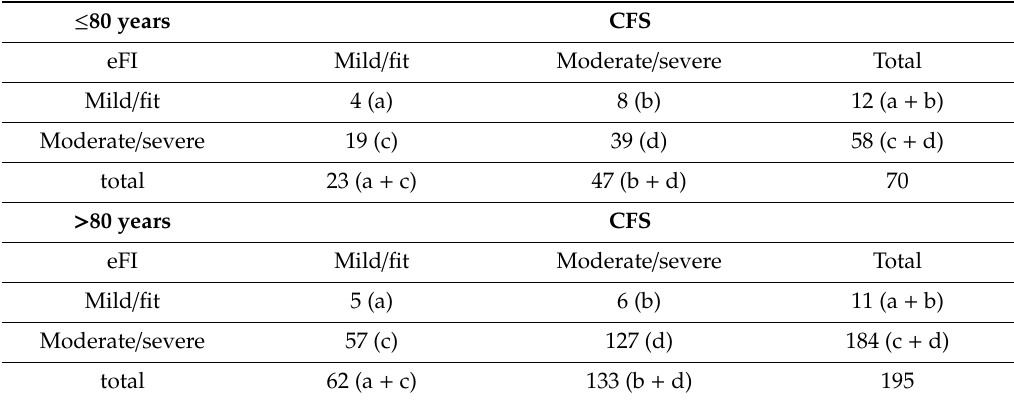
Table 3. Subgroup of electronic Frailty Index (eFI) and the Clinical Frailty Scale (CFS) scores by age. ≤ 80